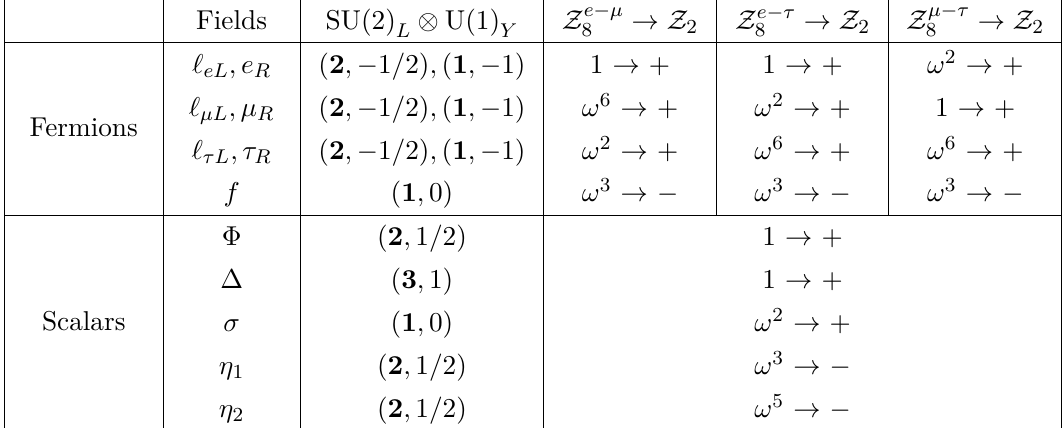
symmetry we have ω k = e ikπ/ 4 8